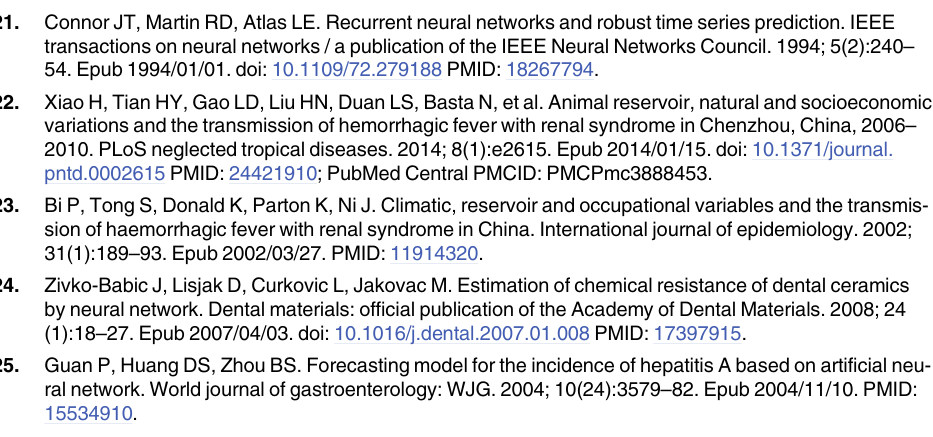
PLOS ONE | DOI:10.1371/journal.pone.0135492 August 13,